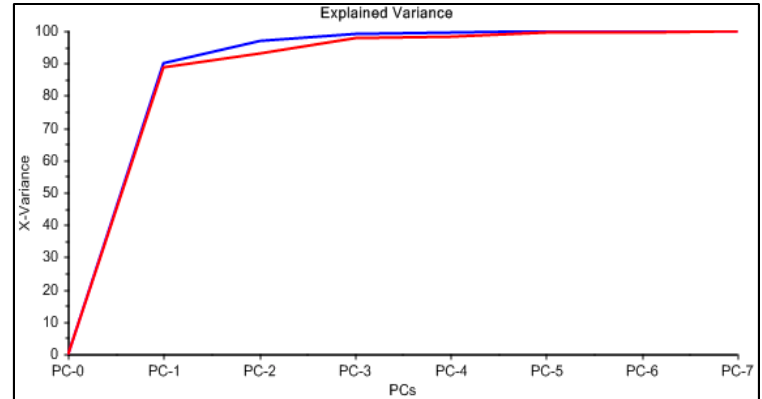
Figure 9. Principal component analysis for the system PAN–Cd(II).